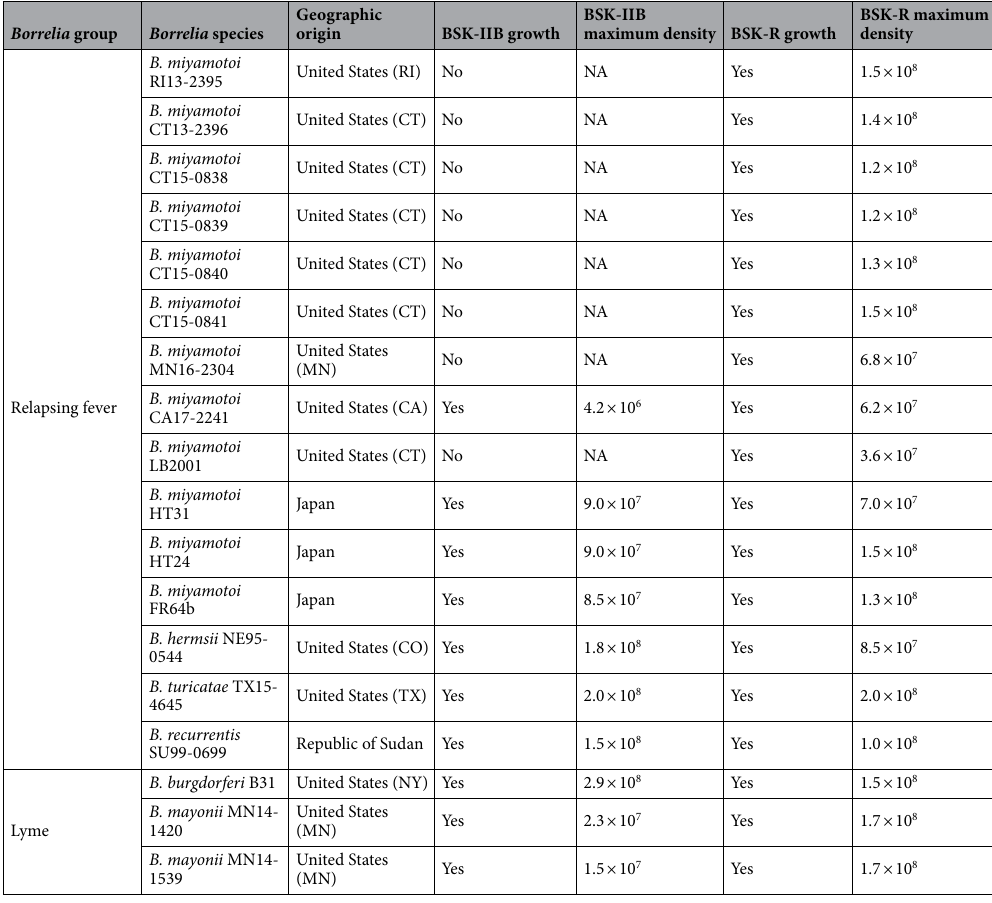
Table 2. Growth comparison of Lyme and relapsing fever Borrelia species in BSK-R and